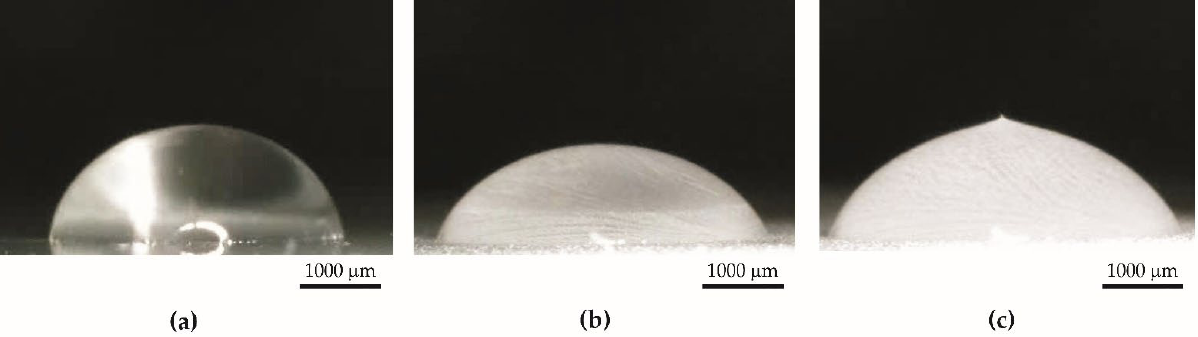
Figure 12. The specimen from Series 1. A drop of water on the specimen surface: ( a ) before icing, ( b ) during icing, ( c ) after complete freezing.